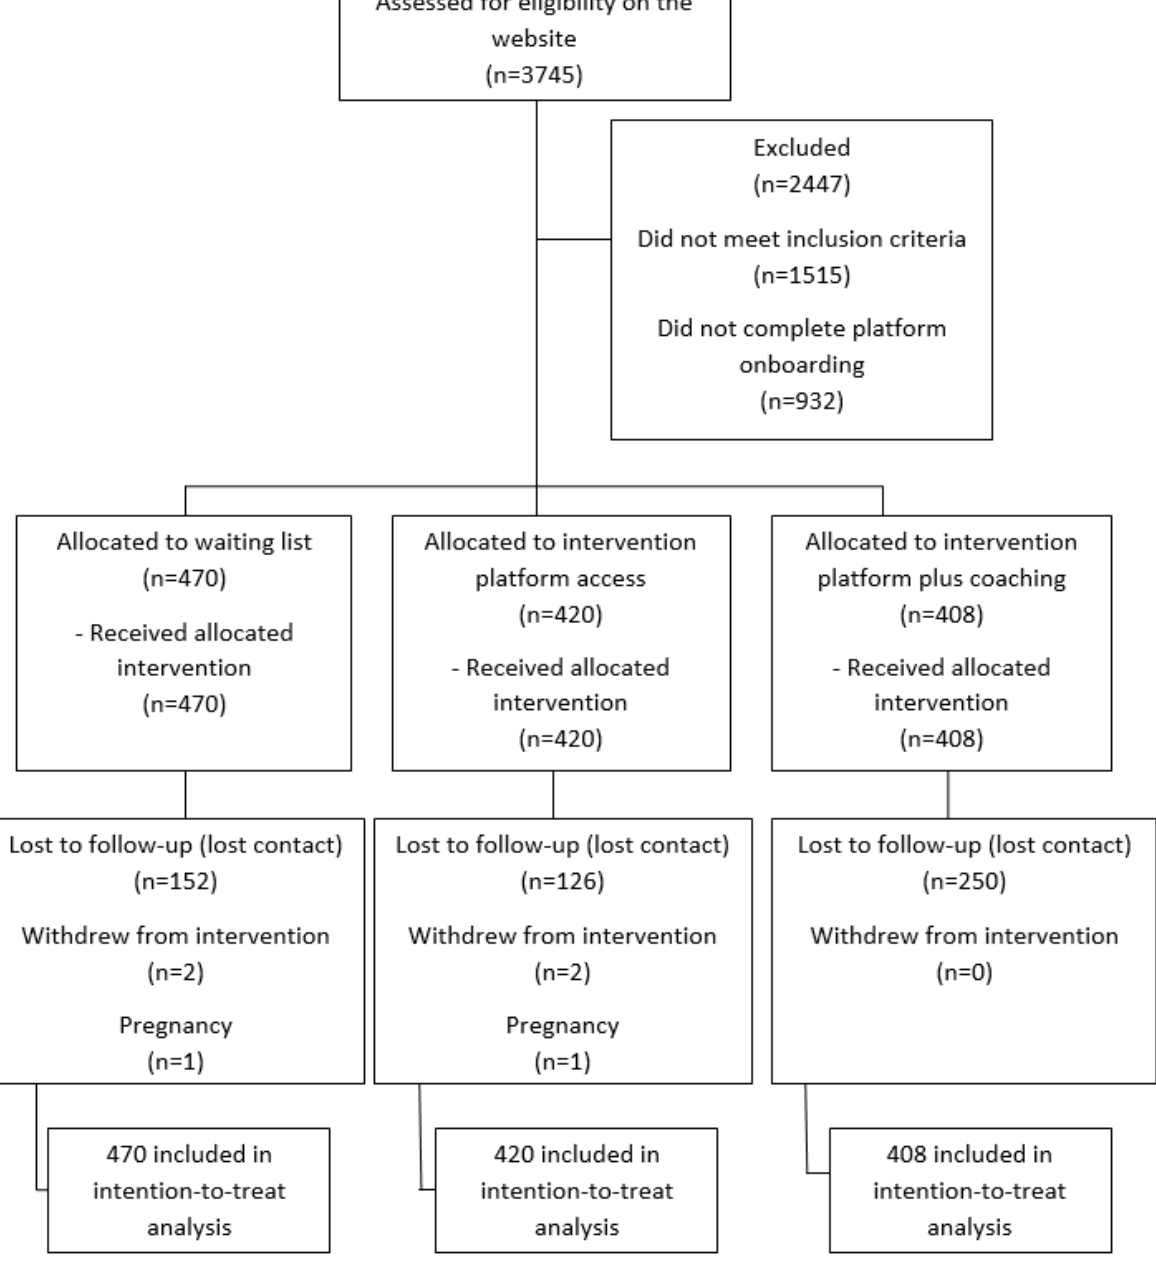
Figure 1. CONSORT flow diagram for the POEmaS randomized controlled trial. CONSORT: Consolidated Standards of Reporting Trials; POEmaS: Online Platform for Healthy Weight